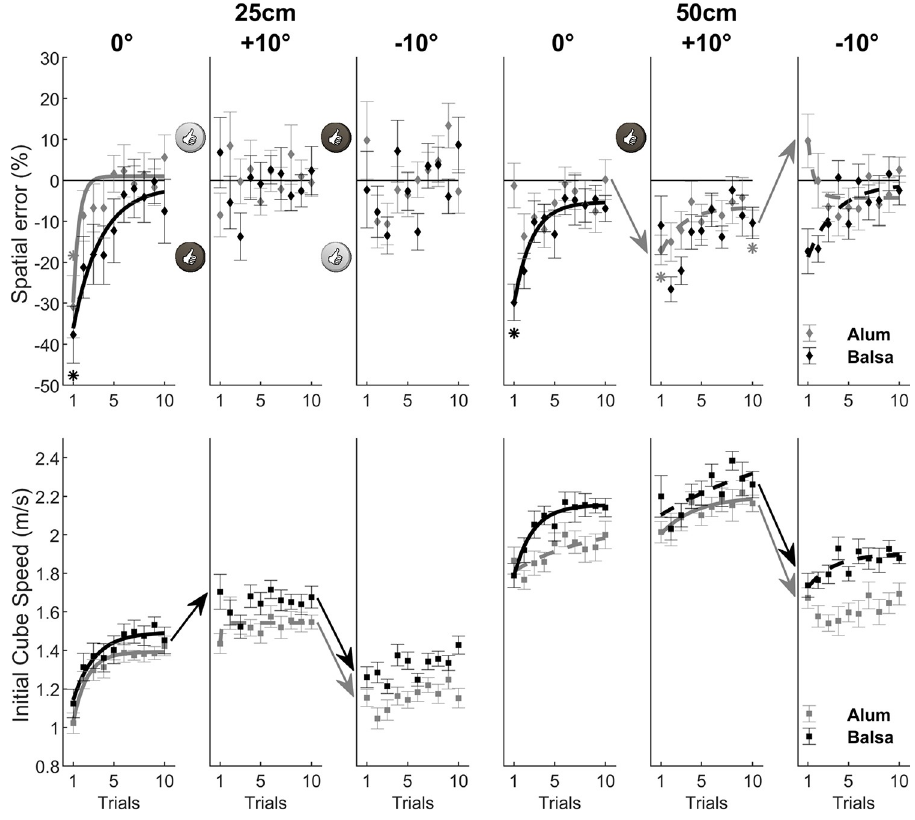
Fig 6. Same as Fig 5, for the “0˚, +10˚, -10˚” block order groups. Again, the results show motor adaptation at the initial block of trials leading to a subjective μ calibration that allowed for adequate movement re-parameterization in the following +10˚ conditions (see 0˚ to +10˚ transition), except for 50 cm with aluminum. Then, movement re- parameterization for the -10˚ to +10˚ transition was successful (see the thumb-up symbols) only in the shorter target distance condition (25